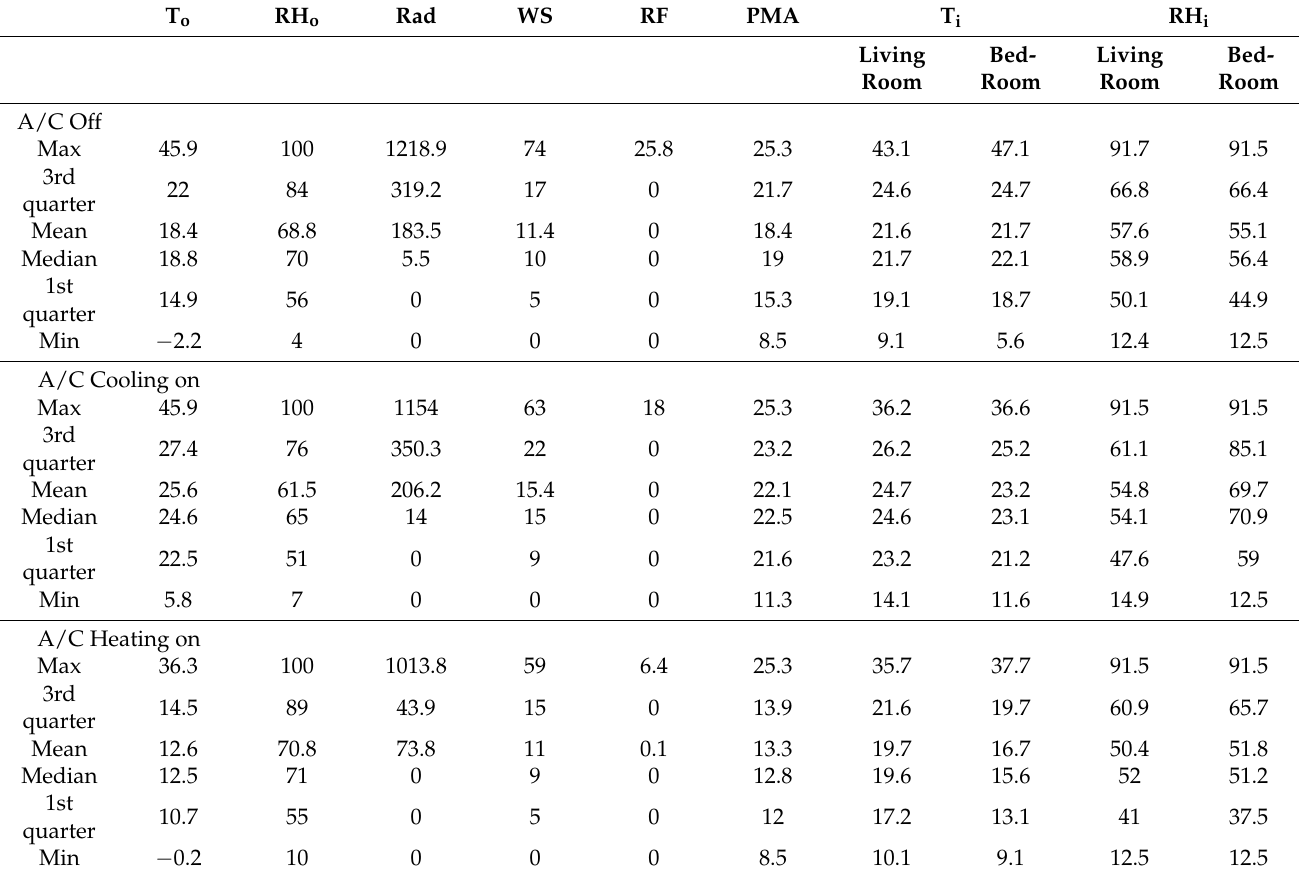
Table 6. Descriptive statistics of monitored data.